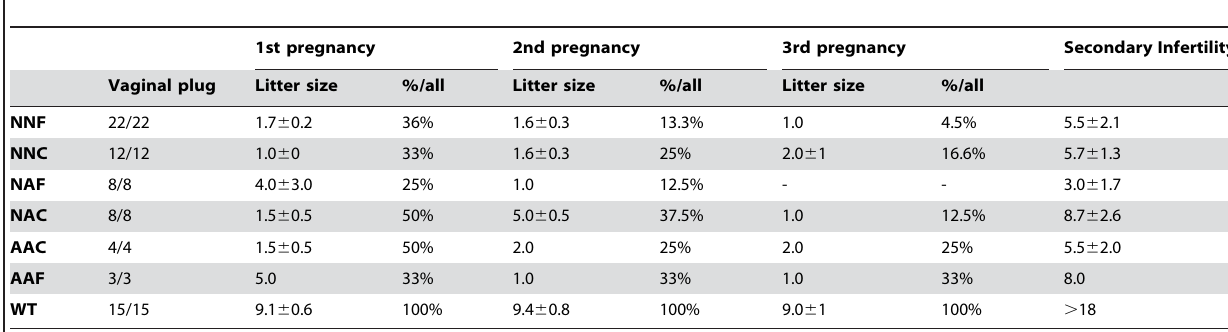
Table 2. Litter sizes following the first, second and third pregnancies, in each group and secondary infertility.